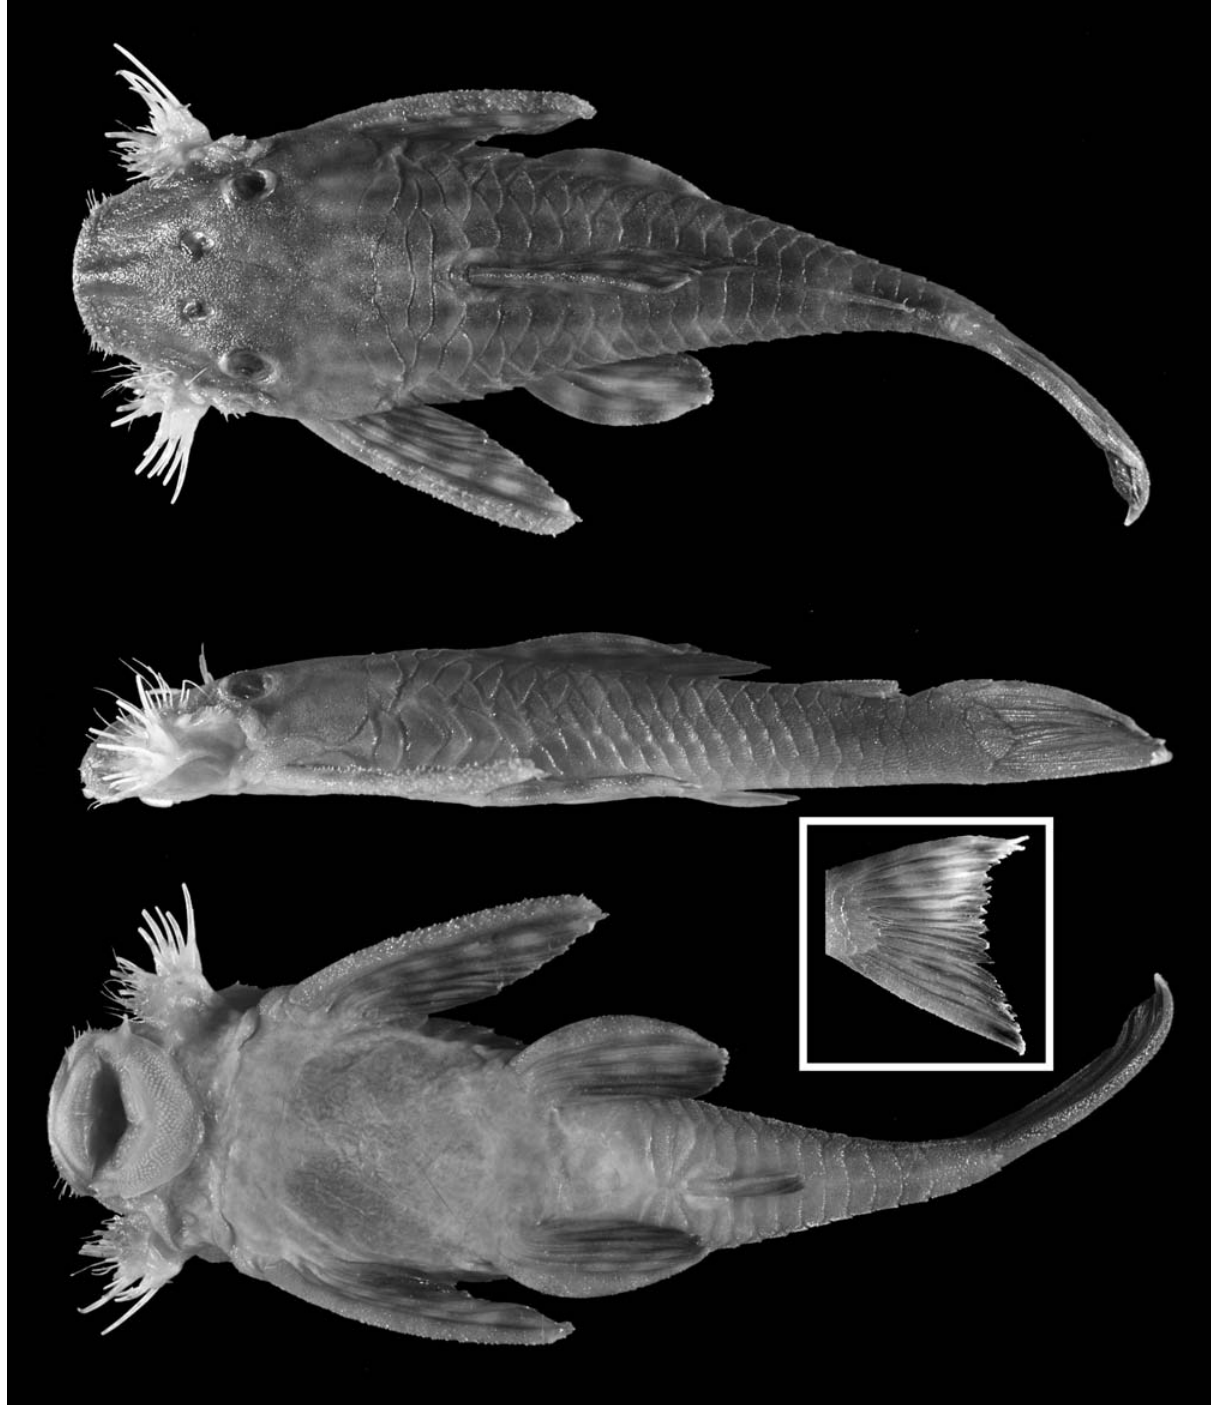
Fig. 4. Dorsal, lateral, and ventral views and inset of extended caudal fin of Lasiancistrus caucanus , SIUC 34914, 92.3 mm